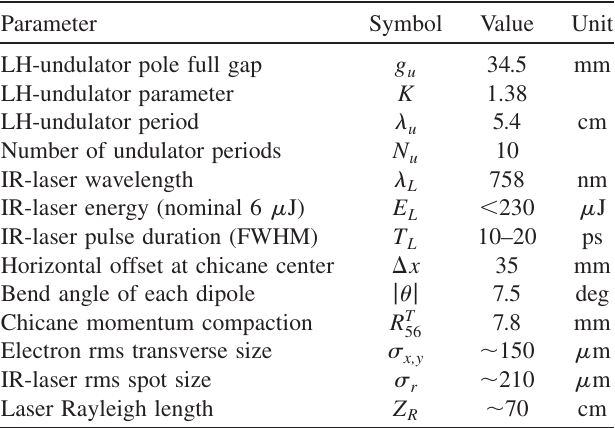
TABLE I. Main parameters for the LCLS laser heater (LH) (at 135 MeV).